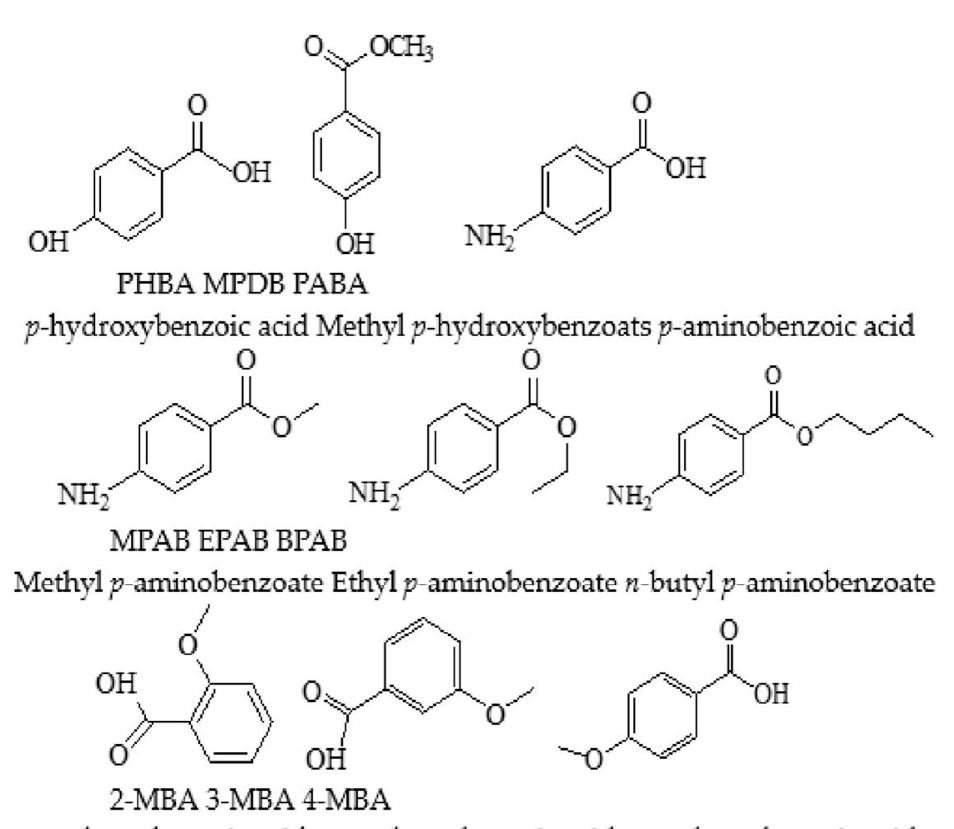
Figure 1. The structure of nine kinds of drugs [19].